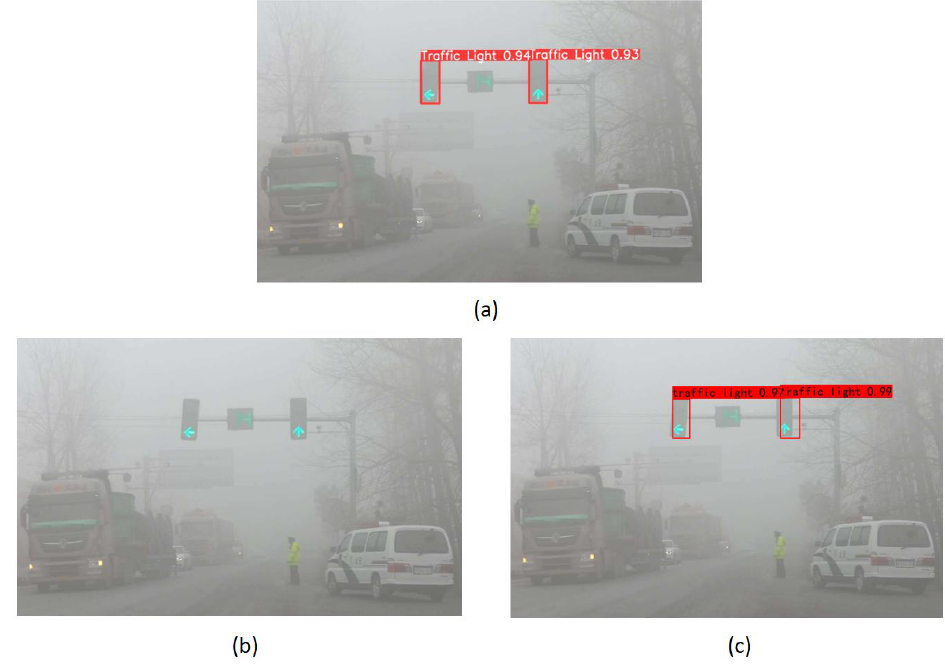
Figure 14. Assay results for YOLOv5s ( a ), YOLOv4 ( b ) and Faster R-CNN ( c ). The detection results of YOLOv5s (a), YOLOv4 (b) and Faster R-CNN (c) are shown